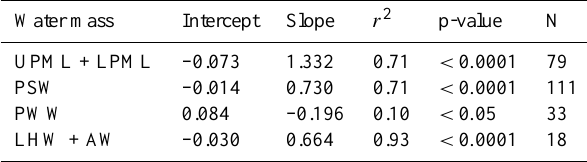
Table A1. Coefficients of the a CDOM (440) versus f CDOM relation- ship for each water mass of the Southern Beaufort